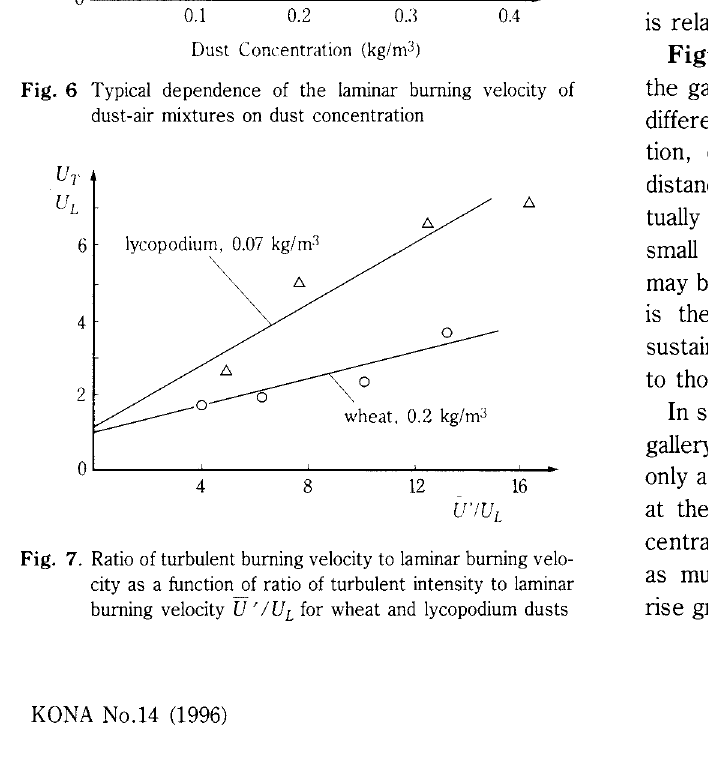
Fig. 7. Ratio of turbulent burning velocity to laminar burning velo city as a function of ratio of turbulent intensity to laminar burning velocity V '!UL for wheat and lycopodium dusts